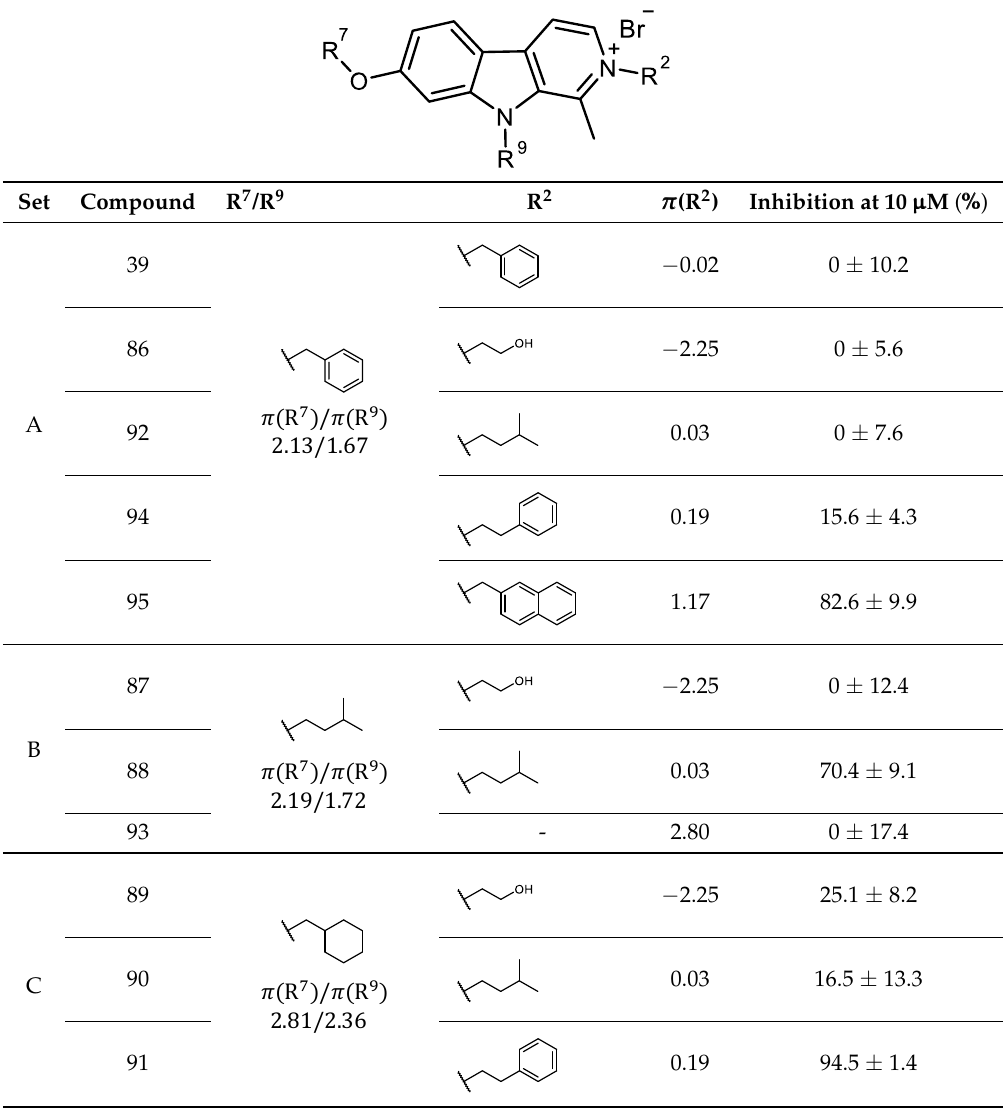
Table 1. Structures of the common 2,7,9-substituted 7-oxy-1-methyl- β -carboline core and inhibition percentages at 10 µM ( ± S.E.) of SerB2’s phosphatase activity for the 7,9-disubstituted and